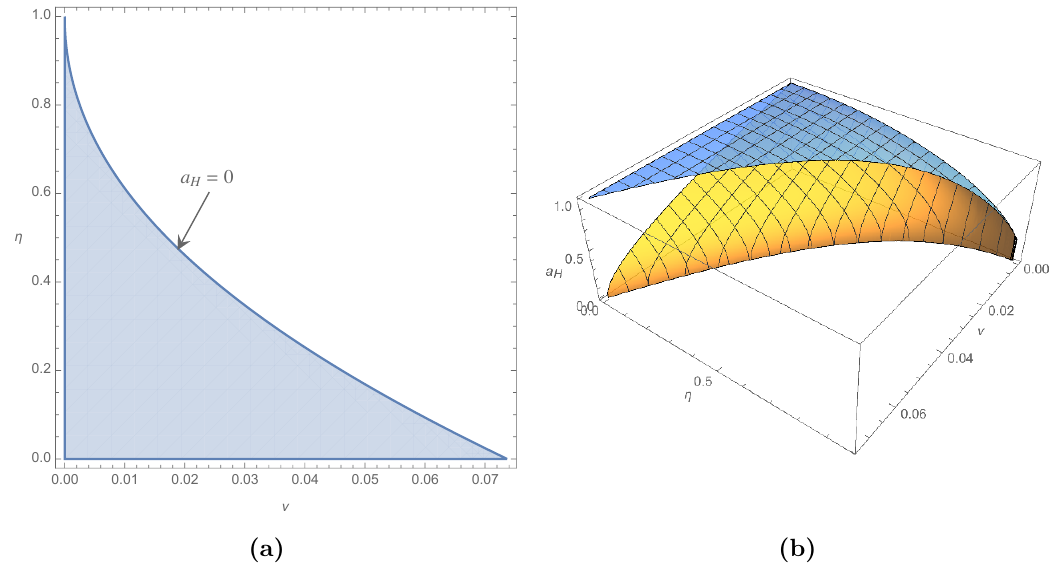
Figure 5. (a) Moduli space for the J = 0 spherical black hole II (0 < a 1 < a 2 , h 0 = 1, h 1 = 1, h 2 = (cid:0) 1). (b) Dimensionless area of the horizon (orange/lighter) as compared to that of the BMPV black hole (blue/darker) in the region of overlap. In this case a H < a BMPV throughout the overlap